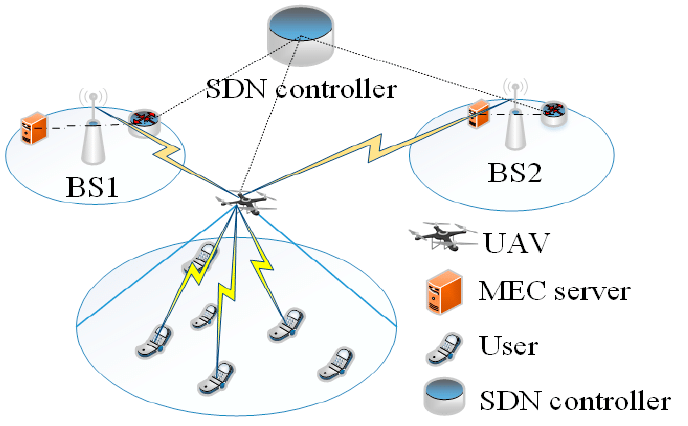
Figure 6. Detection of fake authentication.